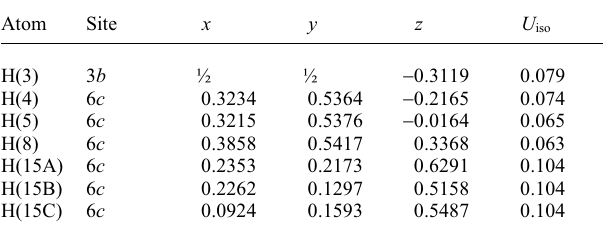
Table 2. Atomic coordinates and displacement parameters (in Å 2 )